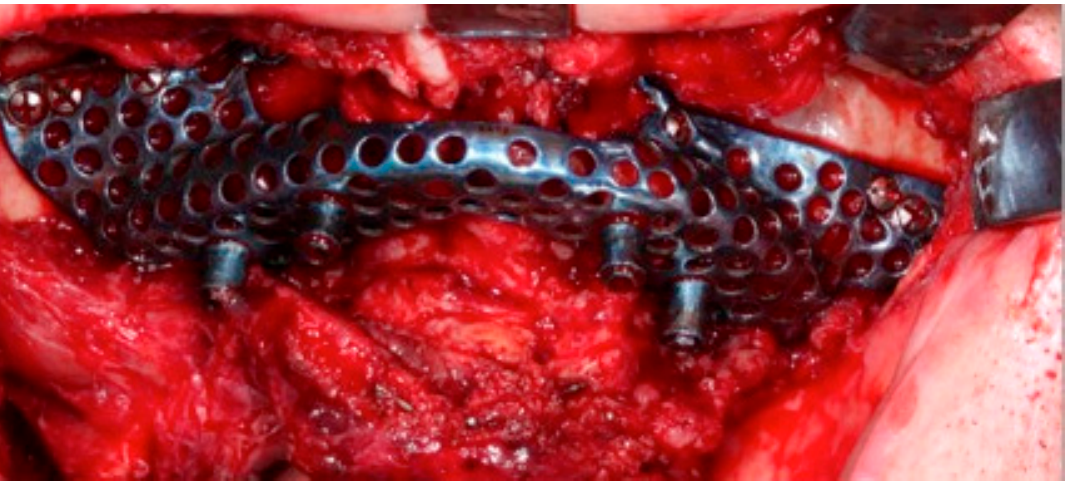
Figure 6. The customised prosthesis was positioned, which was fixed into the nasomaxillary and zygomaticomaxillary buttresses.